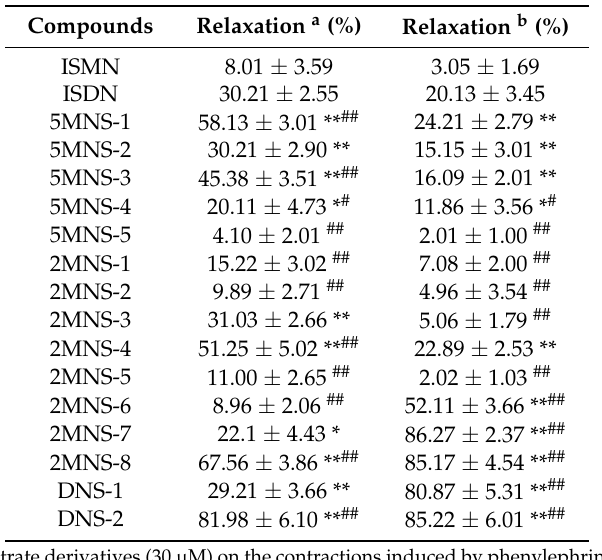
Table 1. Inhibitory effects of nitrate derivatives (30 µ M) on the contractions induced by phenylephrine or KCl in mesenteric artery